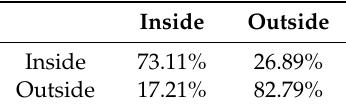
Table 1. Results of the topological test near the border of the queue zone.